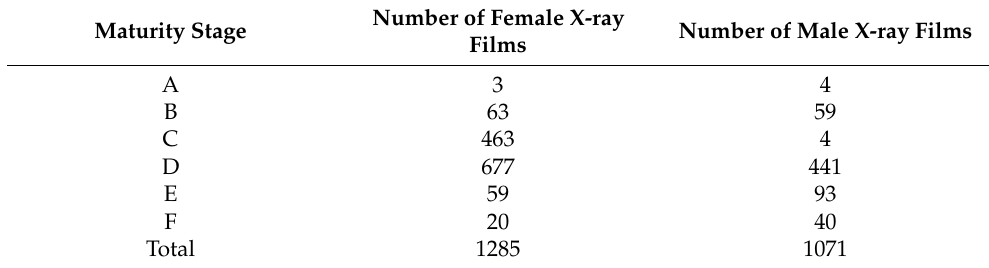
Table 1. Stage distribution of our